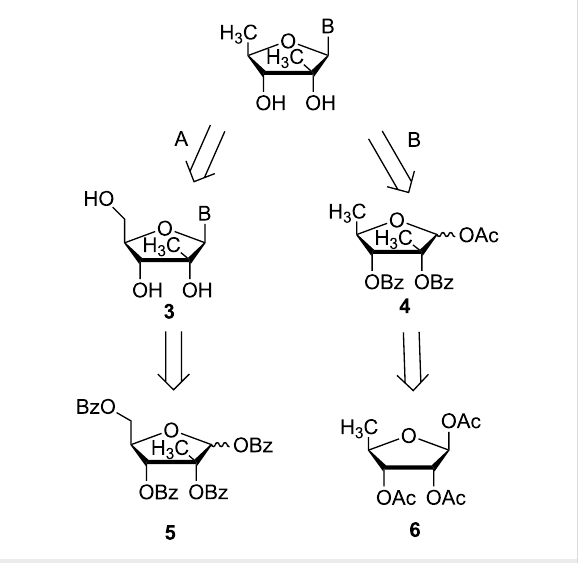
Figure 2: Retrosynthetic analysis of trachycladines A and